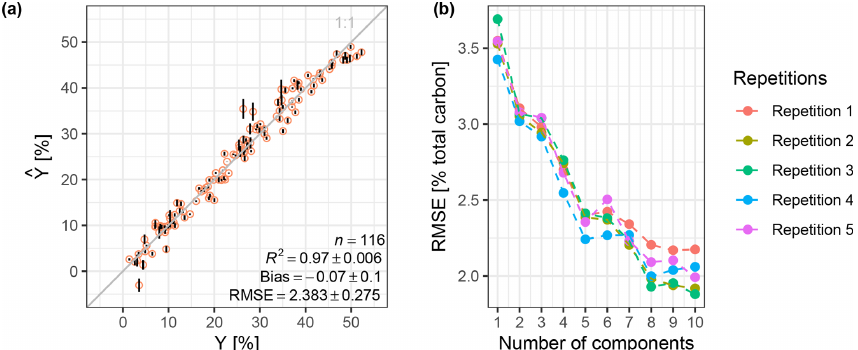
Figure B1. (a) Predicted ˆ Y vs. observed Y total carbon (percent) of all local HAFL samples using a PLSR. (b) Illustrative example of PLSR tuning, showing the calculated RMSE (percent total carbon) vs. the number of components used in each repetition. This model used seven components in the first and fifth repetition and eight components in the second, third and fourth repetition, according to the one SE